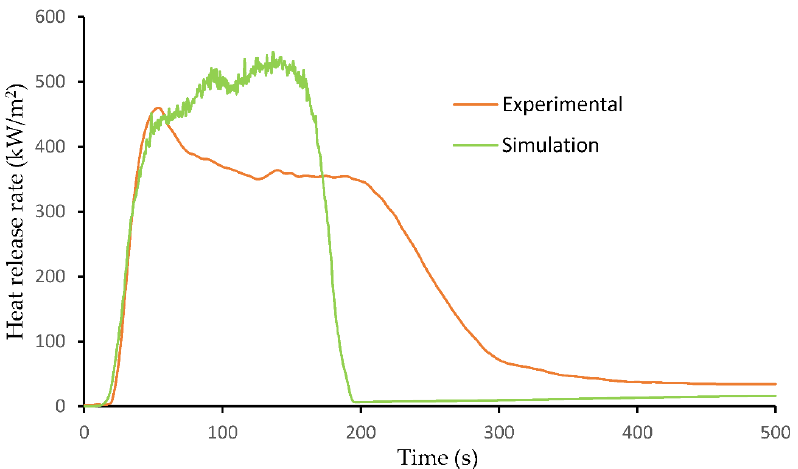
Figure 7. Experimental and numerical HRR curves of IFR-based flax–PP composite at 50 kW/m 2.